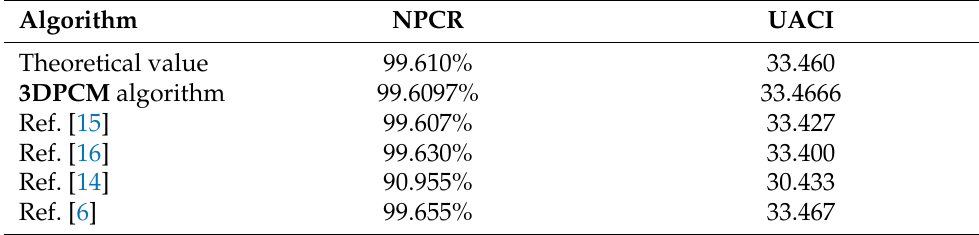
Table 8. NPCR and UACI average values in the 3DPCM algorithm and several other new